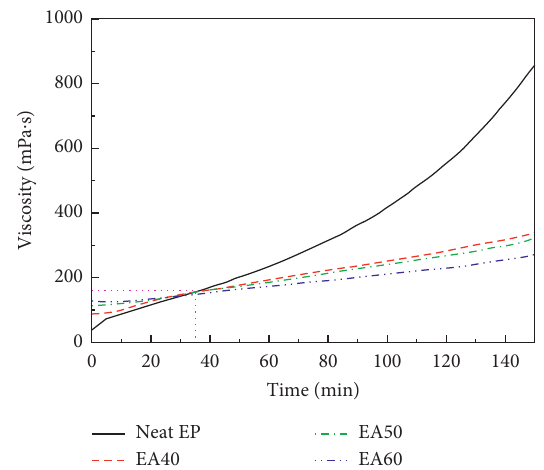
Figure 18: Rotational viscosity versus time for neat EP and EA [81]. Note: EP � epoxy resin; EA � epoxy resin; 40, 50, and 60 � asphalt